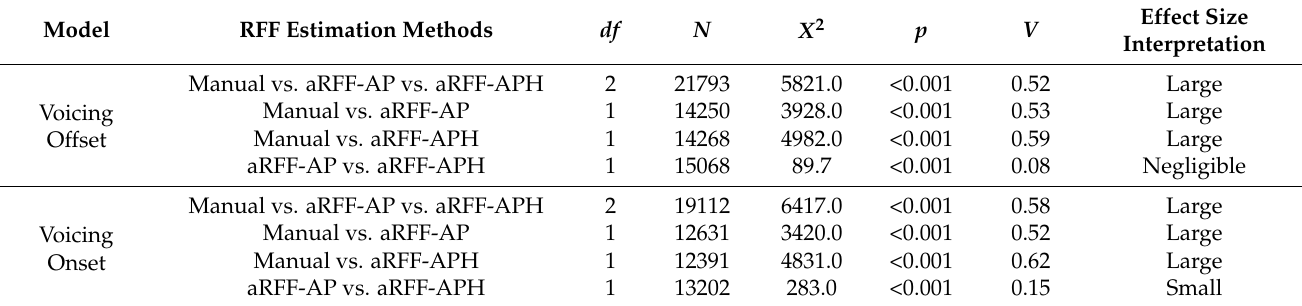
Table 6. Chi-square ( X 2 ) tests of independence to examine RFF estimation method and accuracy of boundary cycle identification for voicing offset and onset. Cramer’s V effect sizes are interpreted using criteria from Cohen [49]. Model